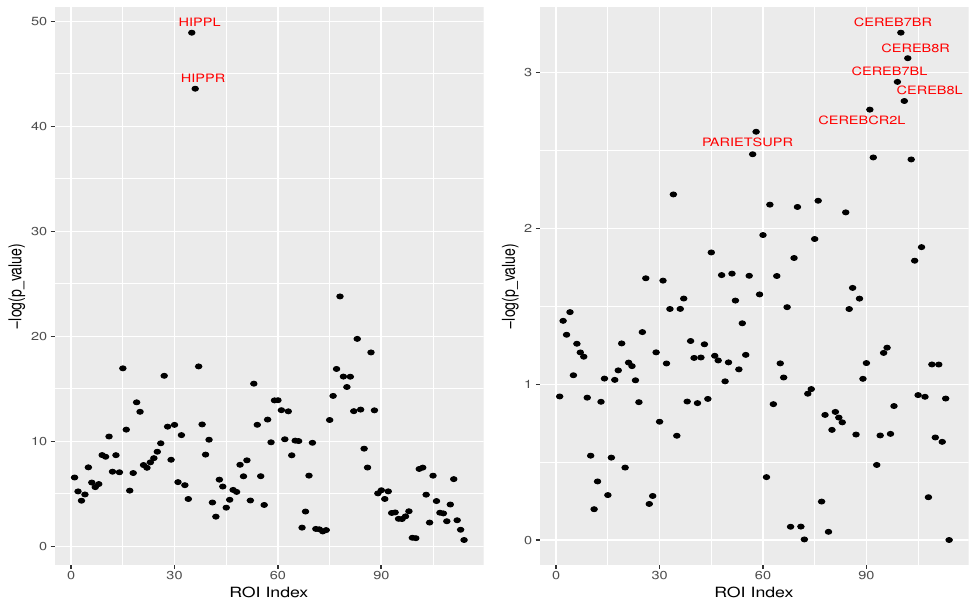
Figure 5. Marginal associations between each of the brain ROIs and one principal component. The x -axis shows the different ROI indices, and the y -axis shows the − log( p _value) obtained from the regression. The left panel is for PC2, and the right one is for PC3, with both having been obtained with whole-brain